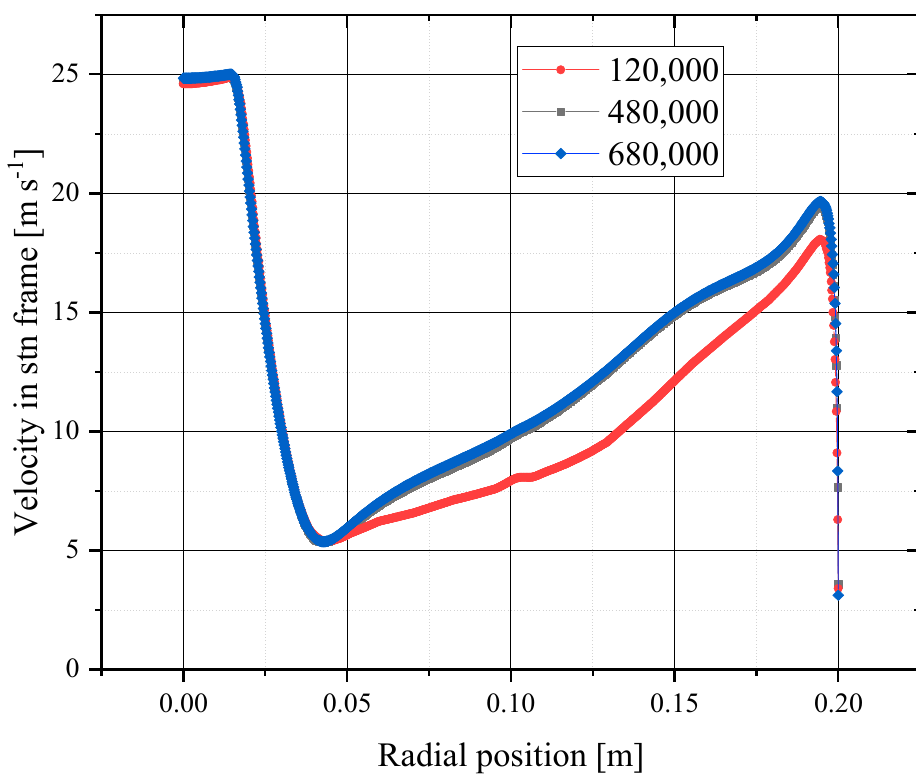
Figure 12. Verification of velocity distribution.